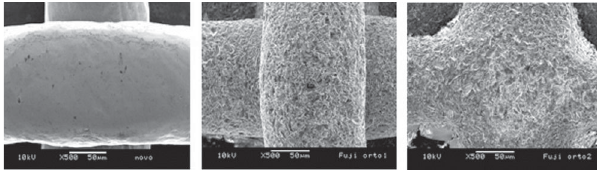
Fig. 5 - Scanning electron micrographs of a bracket base (A) after first (B) and second recycling (C) with aluminum oxide